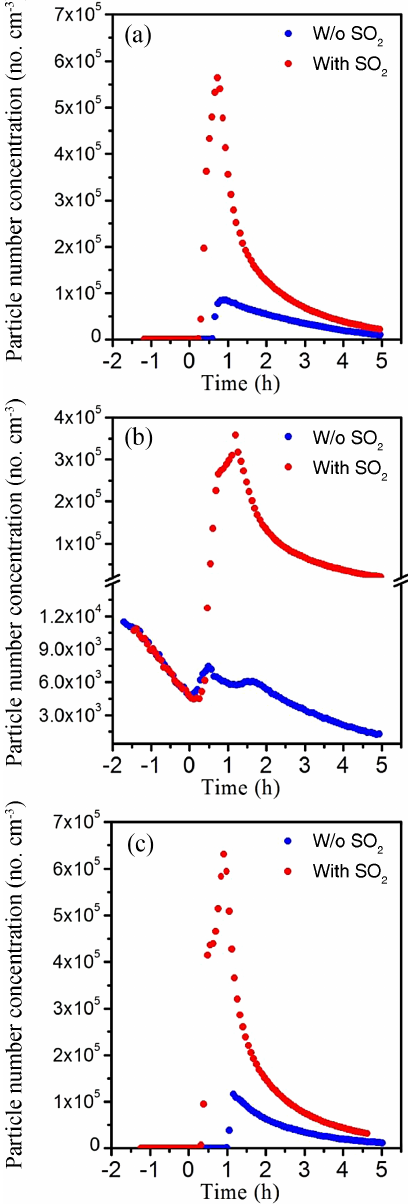
Figure 5. Evolution of particle number concentrations during the aging experiments of LDGV exhaust for vehicle I (a) , II (b) and III (c) . At time = 0h, the black lamps were turned on. “W/o SO 2 ” and “with SO 2 ” in the figures represent experiments without and with addition of SO 2 , respectively.